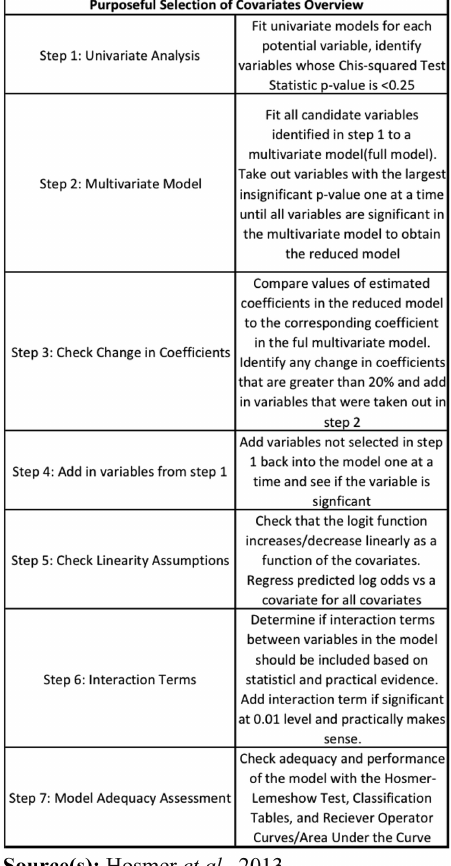
Figure A2. Purposeful selection